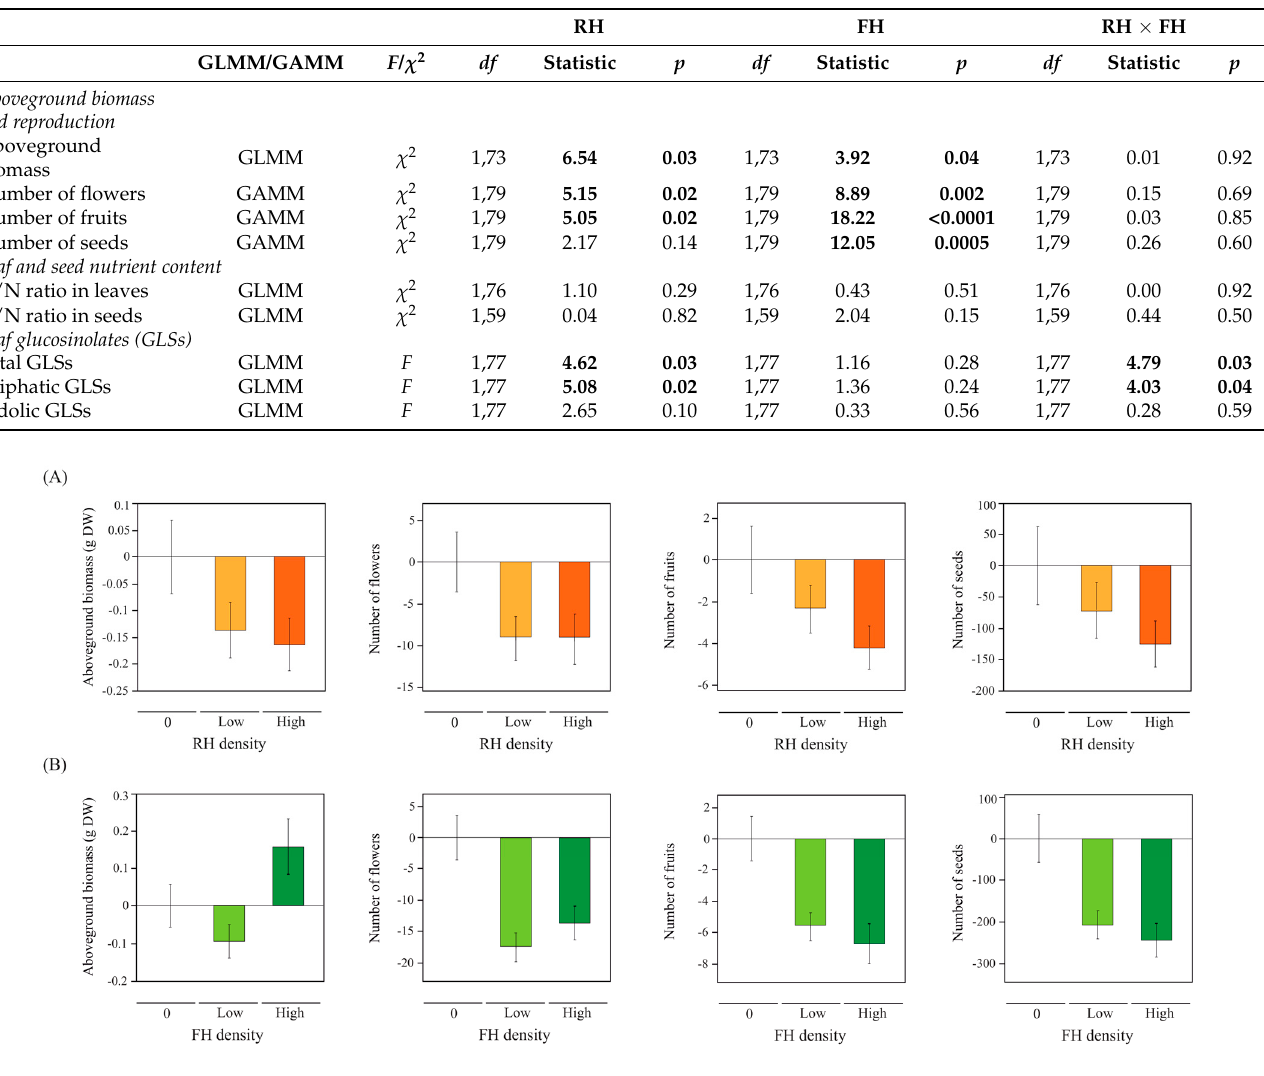
Table 2. GLMM/GAMM results for the effect of root herbivores (RH) and floral herbivores (FH) on plant aboveground biomass, reproductive traits, leaf and seed nutrient content, and leaf glucosinolates (GLSs). Significant values ( P < 0.05) are highlighted in bold.